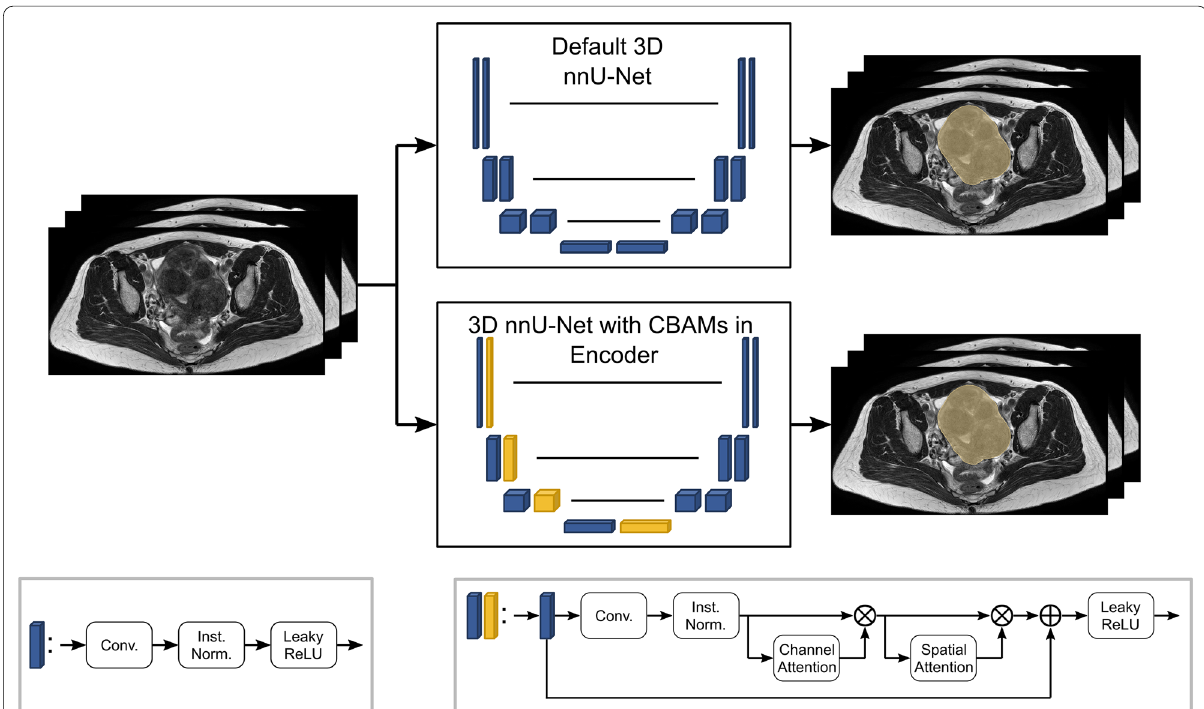
Fig. 1 Schematic illustration of the used architectures: One layer in the default nnU-Net configuration consists of a convolution followed by an instance normalization and a leaky ReLU activation (blue). The modified architecture investigated in this work contains layers with additional CBAMs in the encoder (yellow), consisting of a convolution and an instance normalization followed by a channel and a spatial attention module, each connected by element-wise multiplication. The output of the first convolutional block and the output of the CBAM are merged by element-wise summation and again activated by leaky ReLU activation